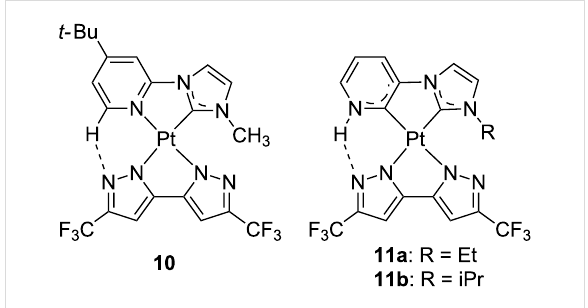
Figure 5: Selected neutral platinum(II) complexes from bipyrazolate and carbene-based chelates